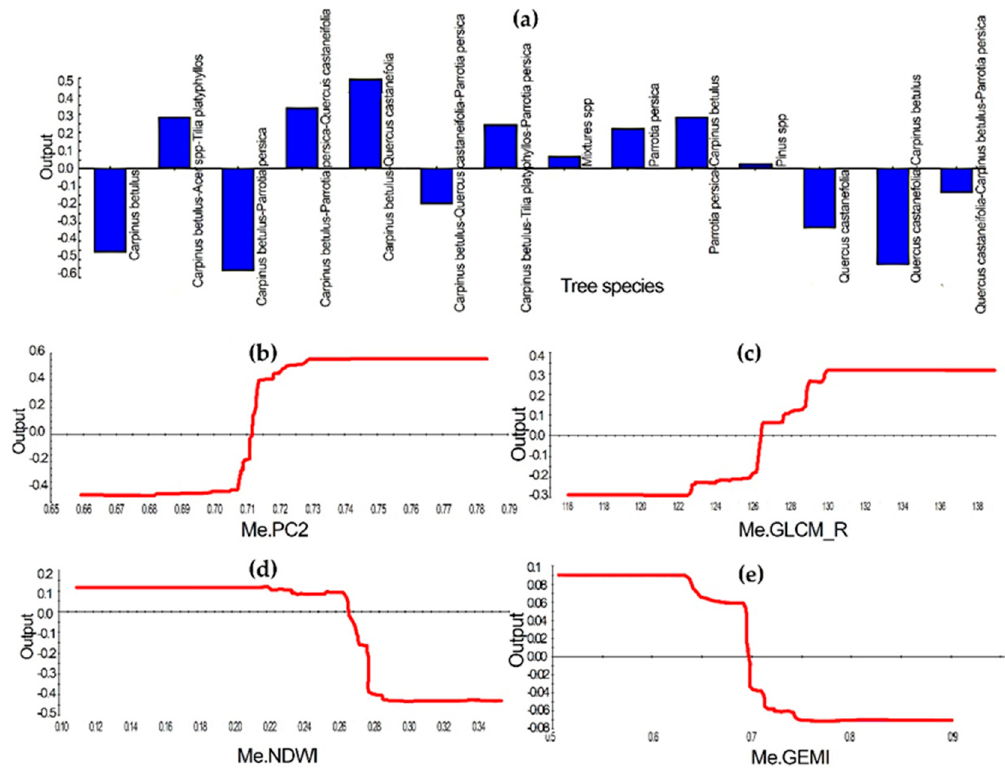
Figure 4. Univariate partial dependency graphs for the top five-predictor variables for classification of insect-infested forests in NE Iran. Positive values of the outputs indicate a direct association of a class of the categorical variables or values of the continuous variables with the focus class. Eight tree species showing positive relationship with the infested class ( a ), the mean of PC2 and the mean of red band derived from GLCM show a positive association at values of greater than 0.711 ( b ) and 126.30 ( c ), and the mean values of the NDWI and GEMI show a positive relationship with the presence of infestation until the values of 0.267 ( d ) and 0.697 ( e ).